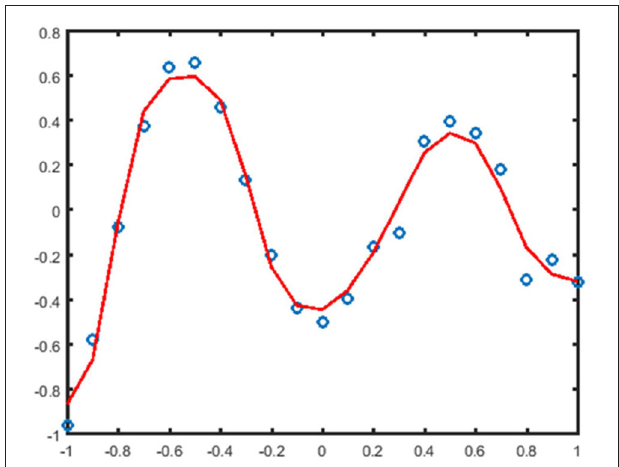
FIGURE 6 | Clustering effect map of the data after noise.